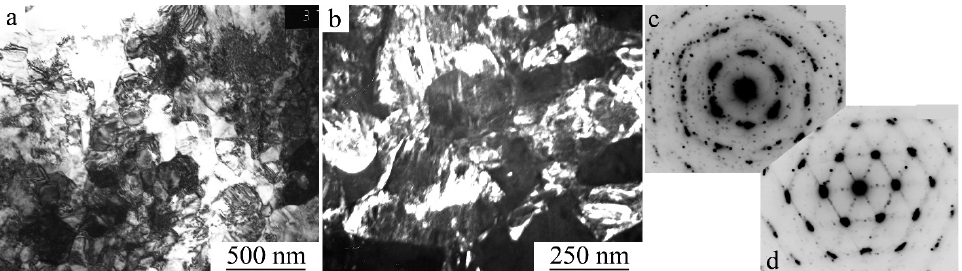
Figure 26. ( a ) Bright- and ( b ) dark-field TEM images, and ( c , d ) SAED patterns (( c )—SD 1.0 µm, ( d )—z.a. close to [111] В 2 || [111] R || [110] B 19’ , SD 0.3 µm), taken from the Ti 49 Ni 51 alloy after MPR to 30% and PDHT at 773 К for 1 h.